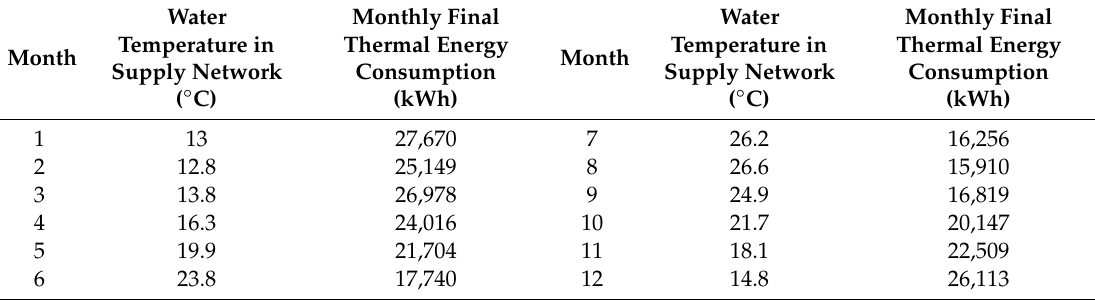
Table 1. Monthly thermal energy required for hot water production in the Pancretan Stadium.